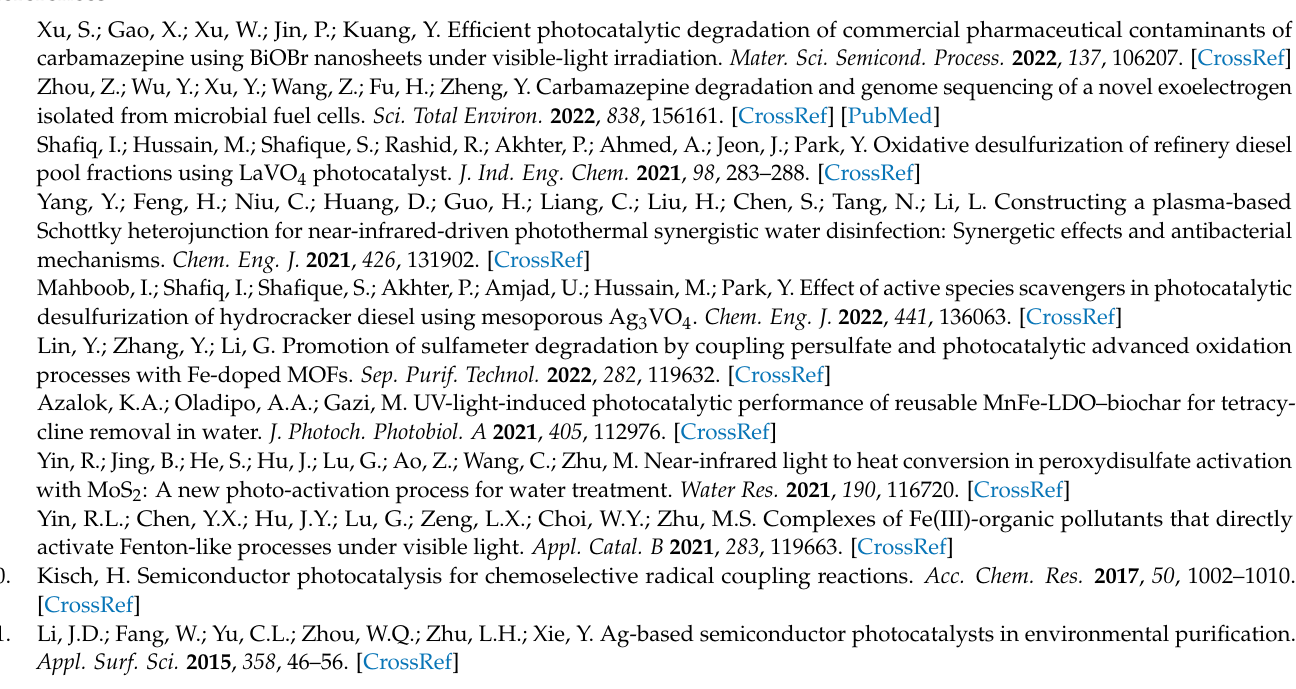
Table S1: Compounds identified by LC-MS during the photocatalytic degradation of CBZ under visible light irradiation; Figure S1: Survey XPS spectrum of the Bi2WO6 sample; Figure S2: The degradation of CBZ in the VL/Bi2WO6/PMS system under N2